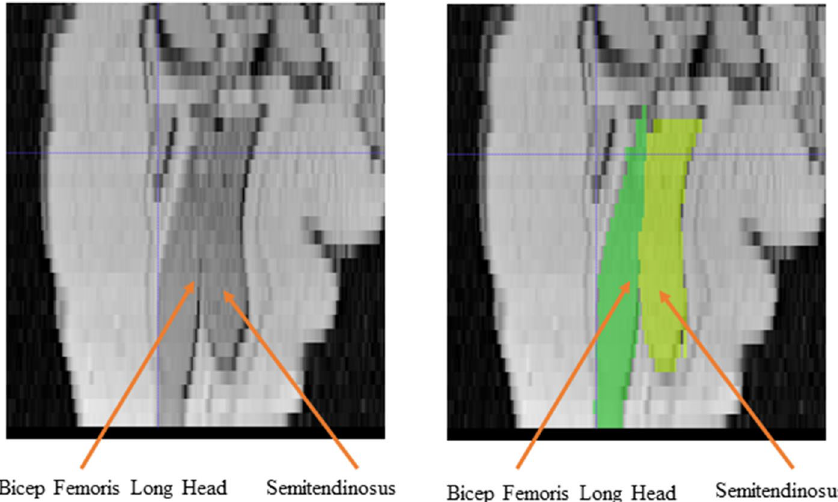
Figure 3. A coronal view of a left thigh (the posterior view) highlighting the challenges faced in segmenting muscles sharing intimate borders, here the proximal region of long head of the biceps femoris and the semitendinosus